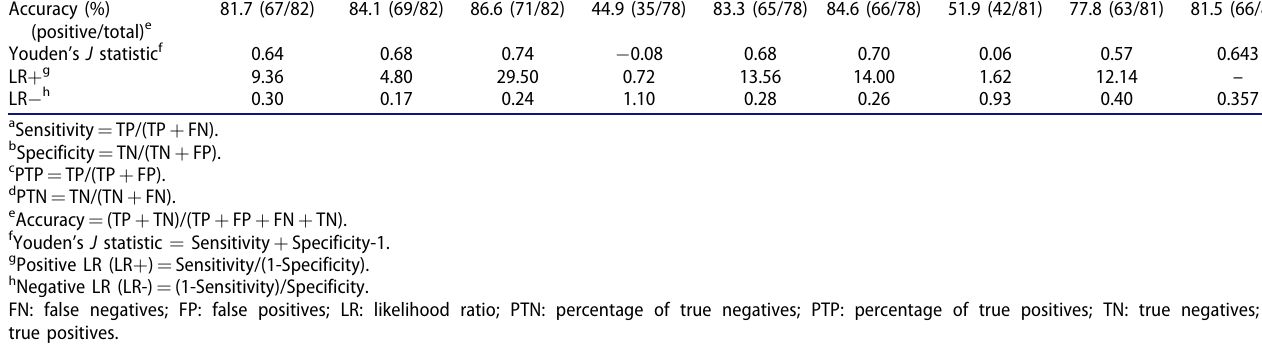
Table 4. Combination of antibodies useful for diagnosis of SCC and AC.